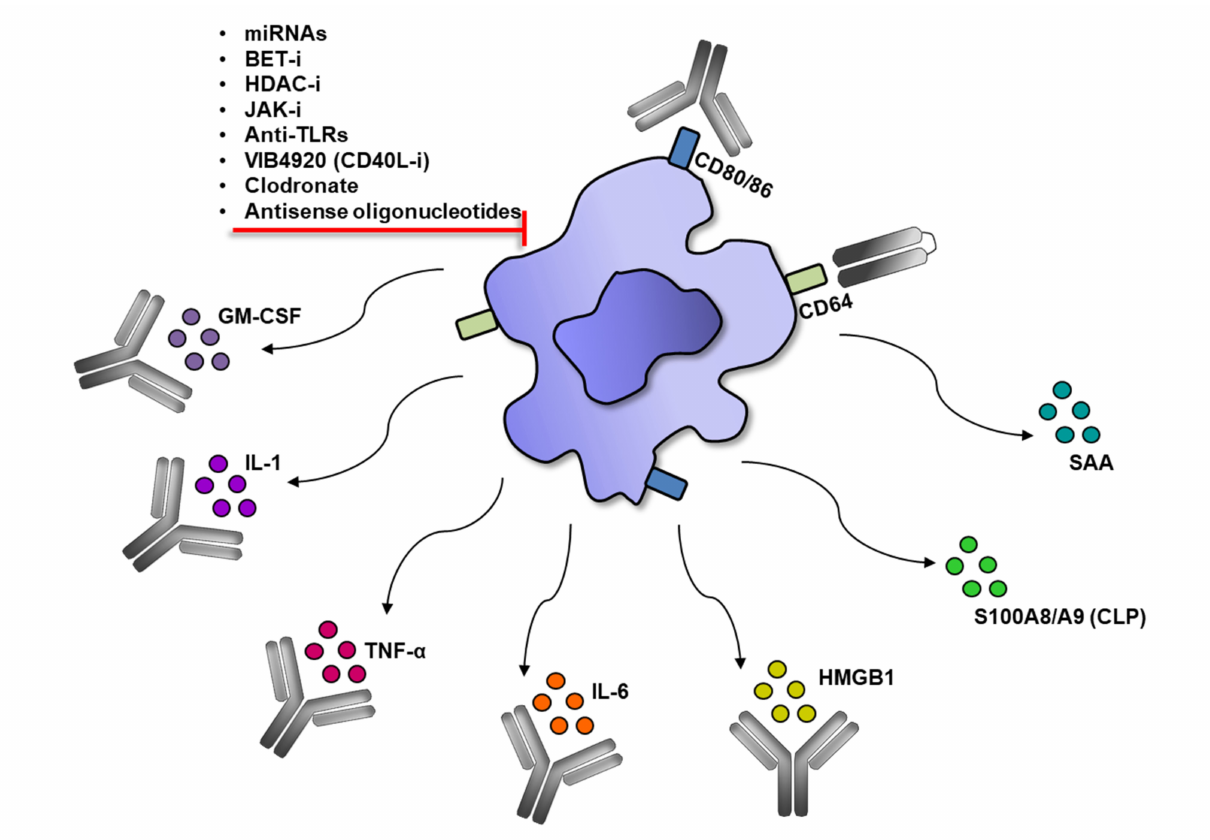
Figure 3. Modulation of macrophage in RA. Activated macrophages produce pro-inflammatory molecules which can be neutralized by monoclonal antibodies or inhibited by chemical agents and